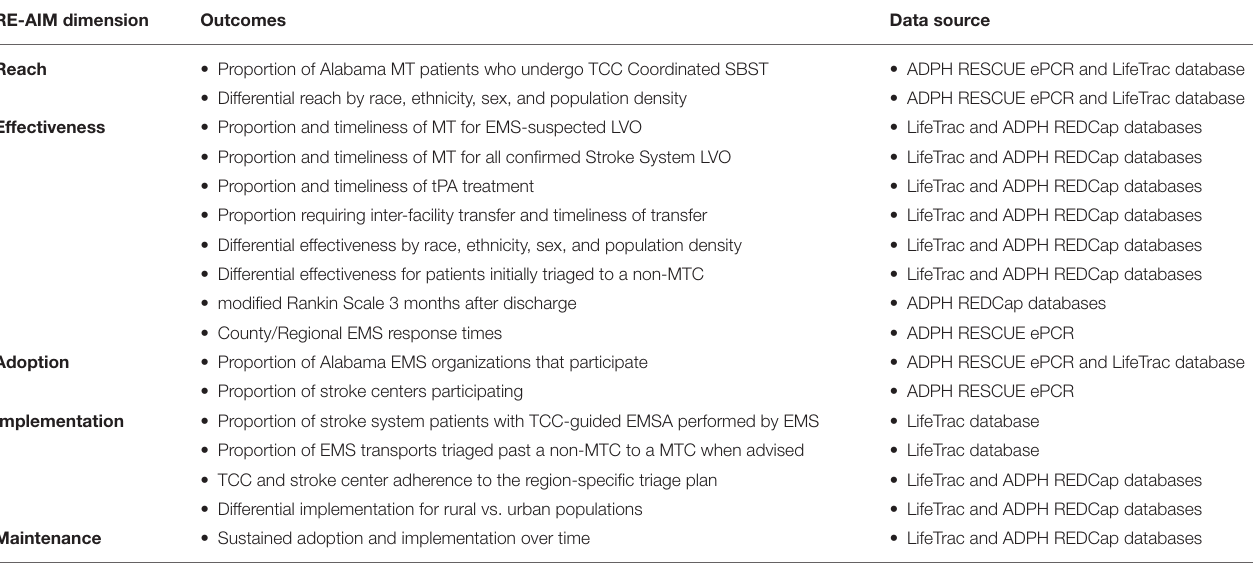
TABLE 3 | RE-AIM framework to evaluate the public health impact of TCC Coordinated SBST. RE-AIM dimension